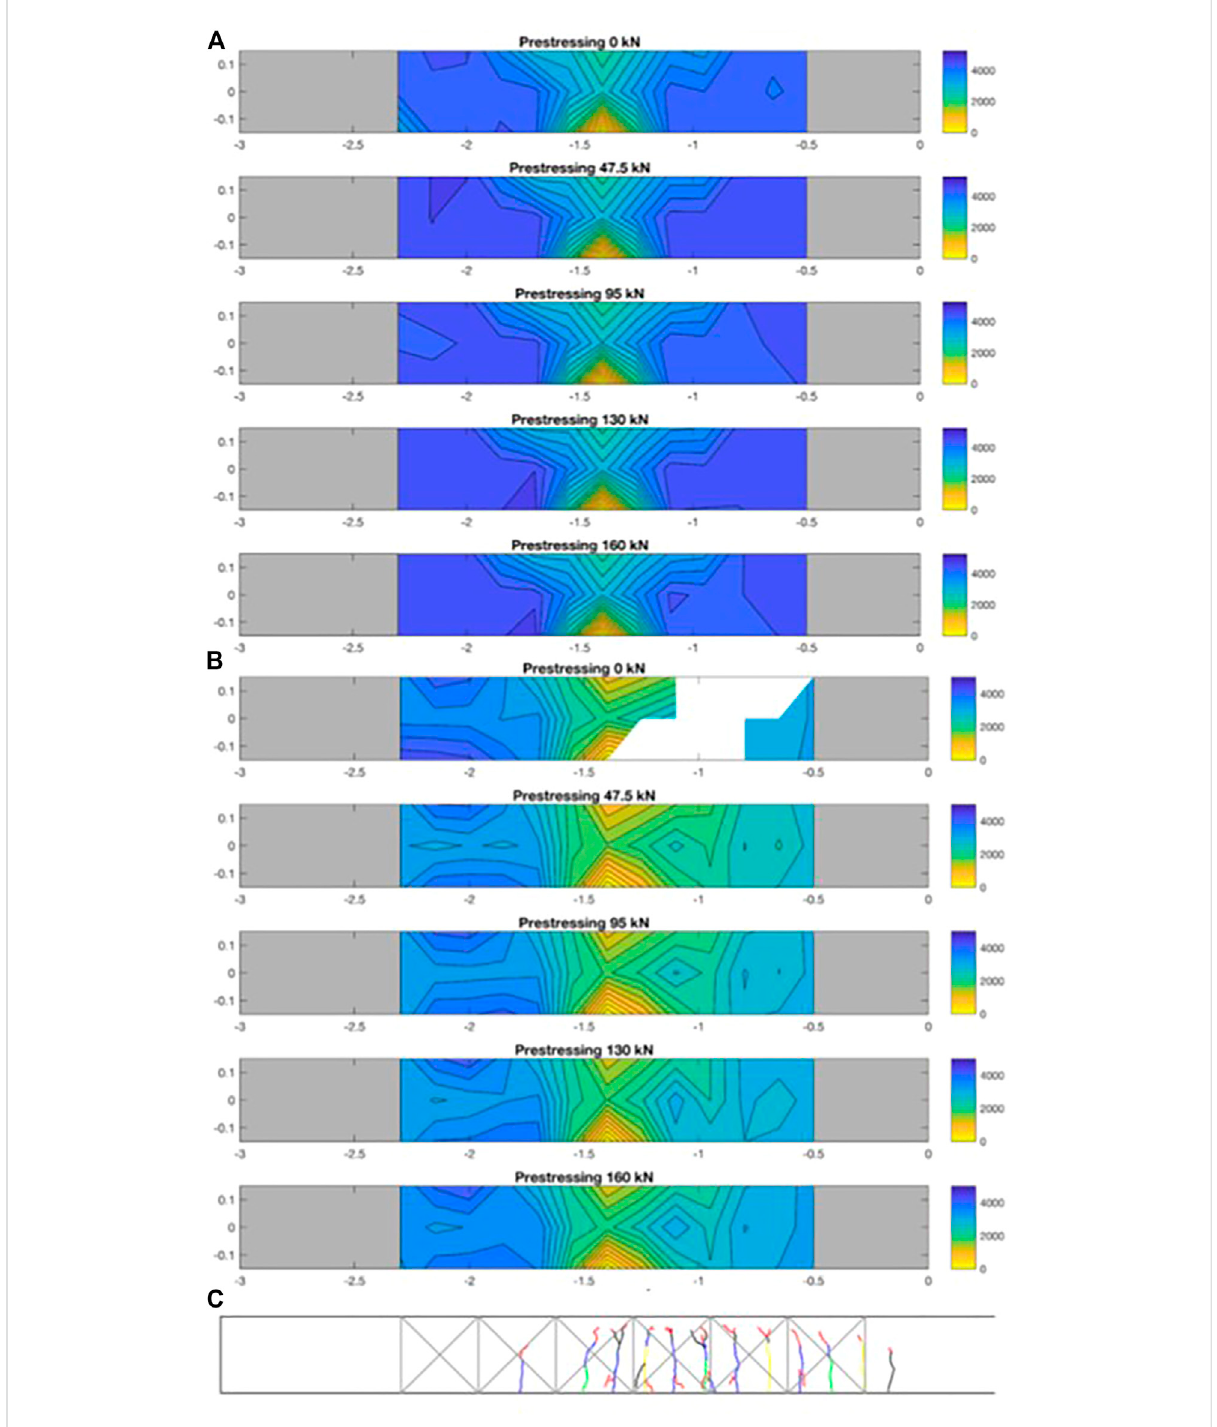
FIGURE 6 UPV tomography (m/s) in the vertical direction (PTC cross-section height = 0.3 m) of Beam 1 in (A) undamaged condition, (B) after complete damage, and (C) cracking pattern at failure.